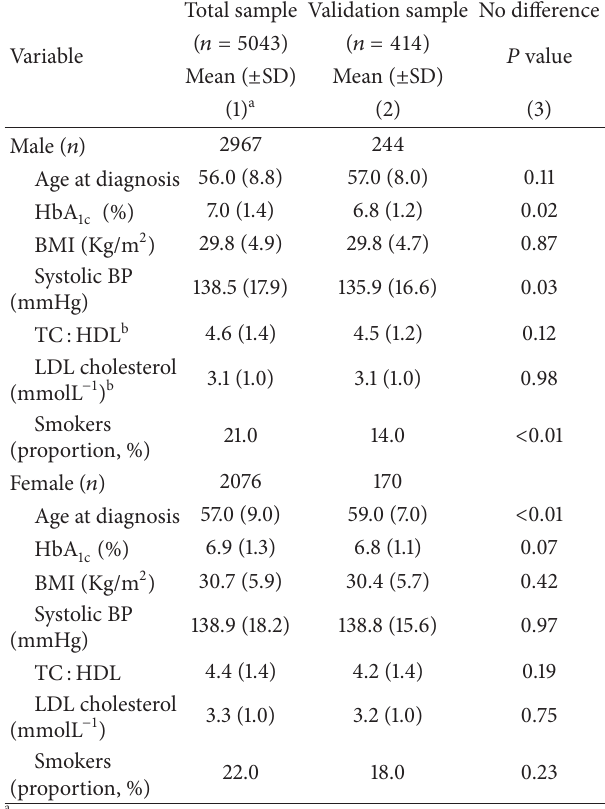
Table 1: Total and validation samples characteristics in the year of diagnosis of